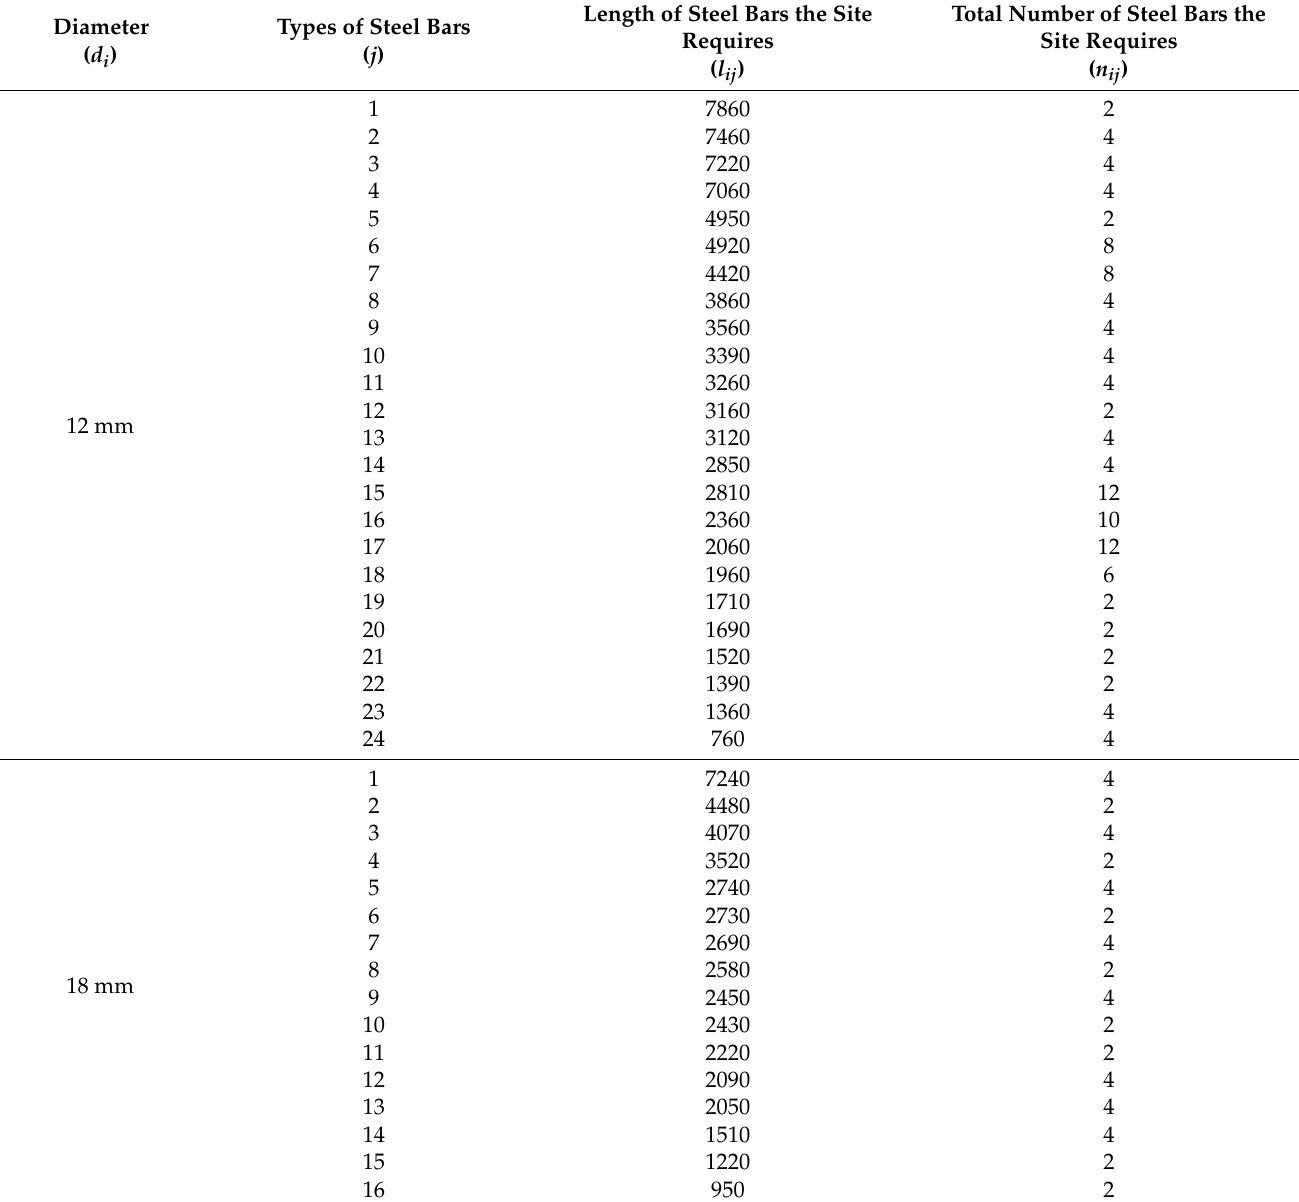
Table 4. Data for the required numbers of steel bars of diameter 12 mm and diameter 18